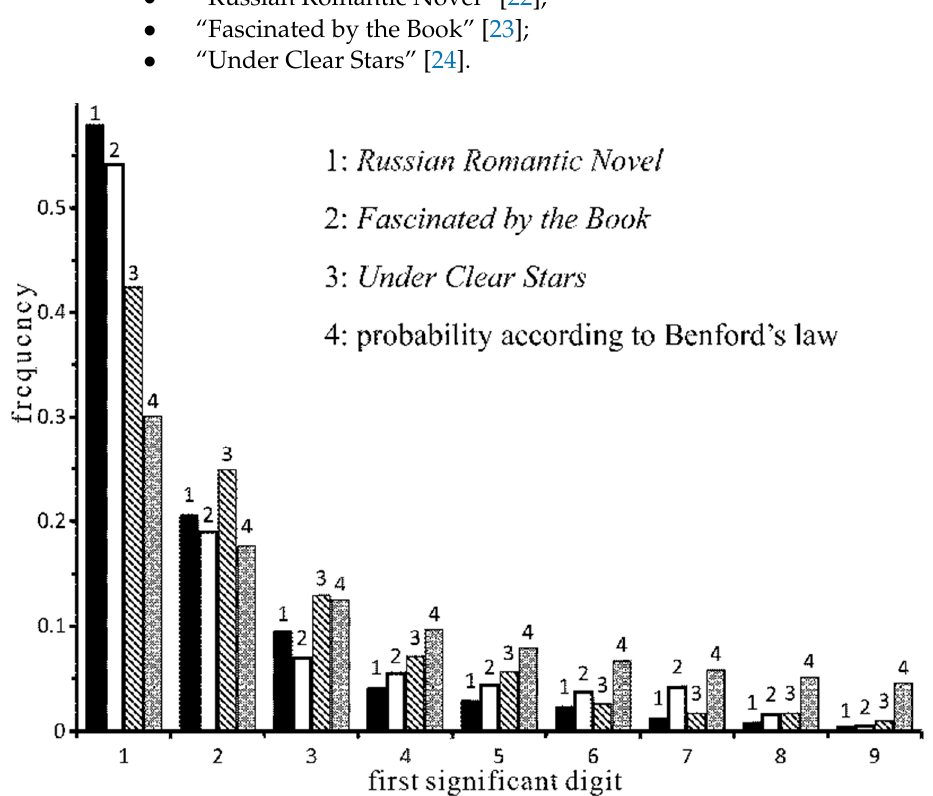
Figure 1. The frequency distribution of the first significant digits of numerals in three collections of Russian-language literary texts. Results are compared with those prescribed by Benford’s